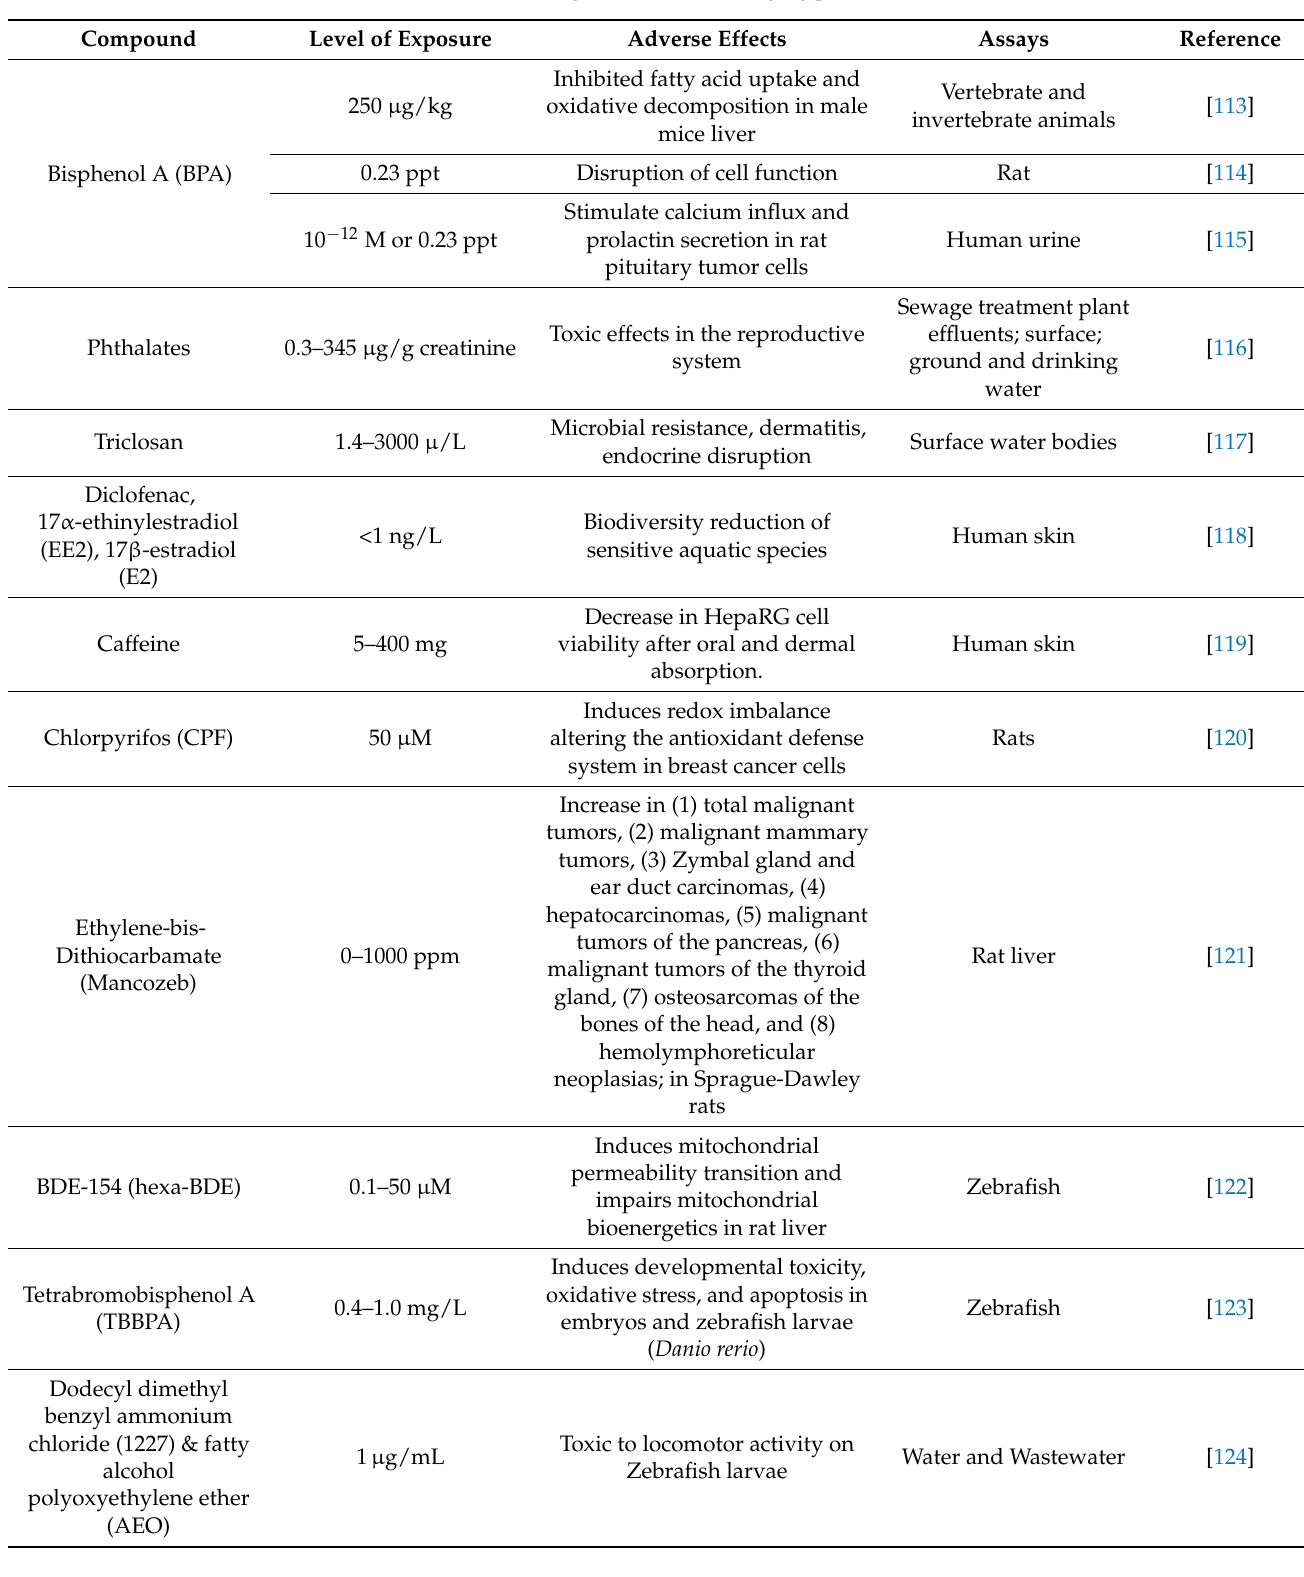
Table 3. Toxicological effects of emerging